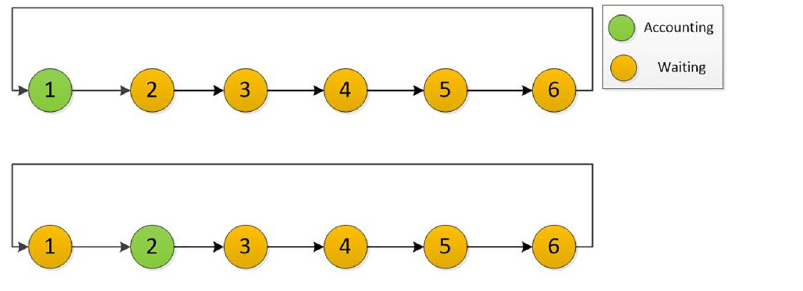
Fig 4. Accounting sequence.